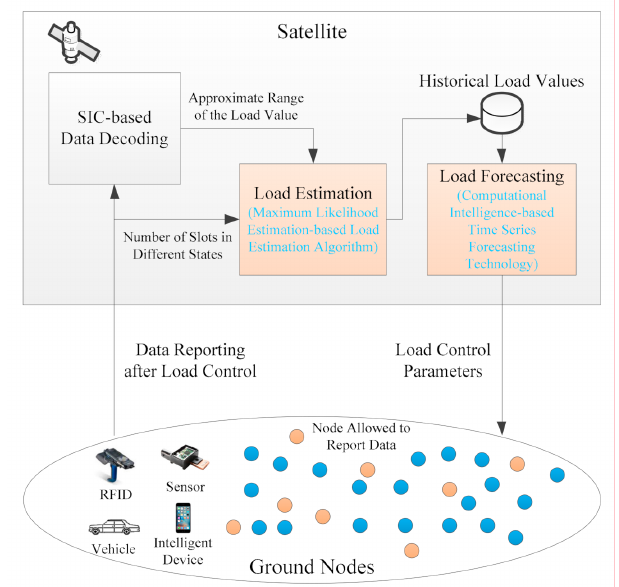
Figure 1. The framework of the load control-based three-replica contention resolution diversity slotted ALOHA (LC-CRDSA3)